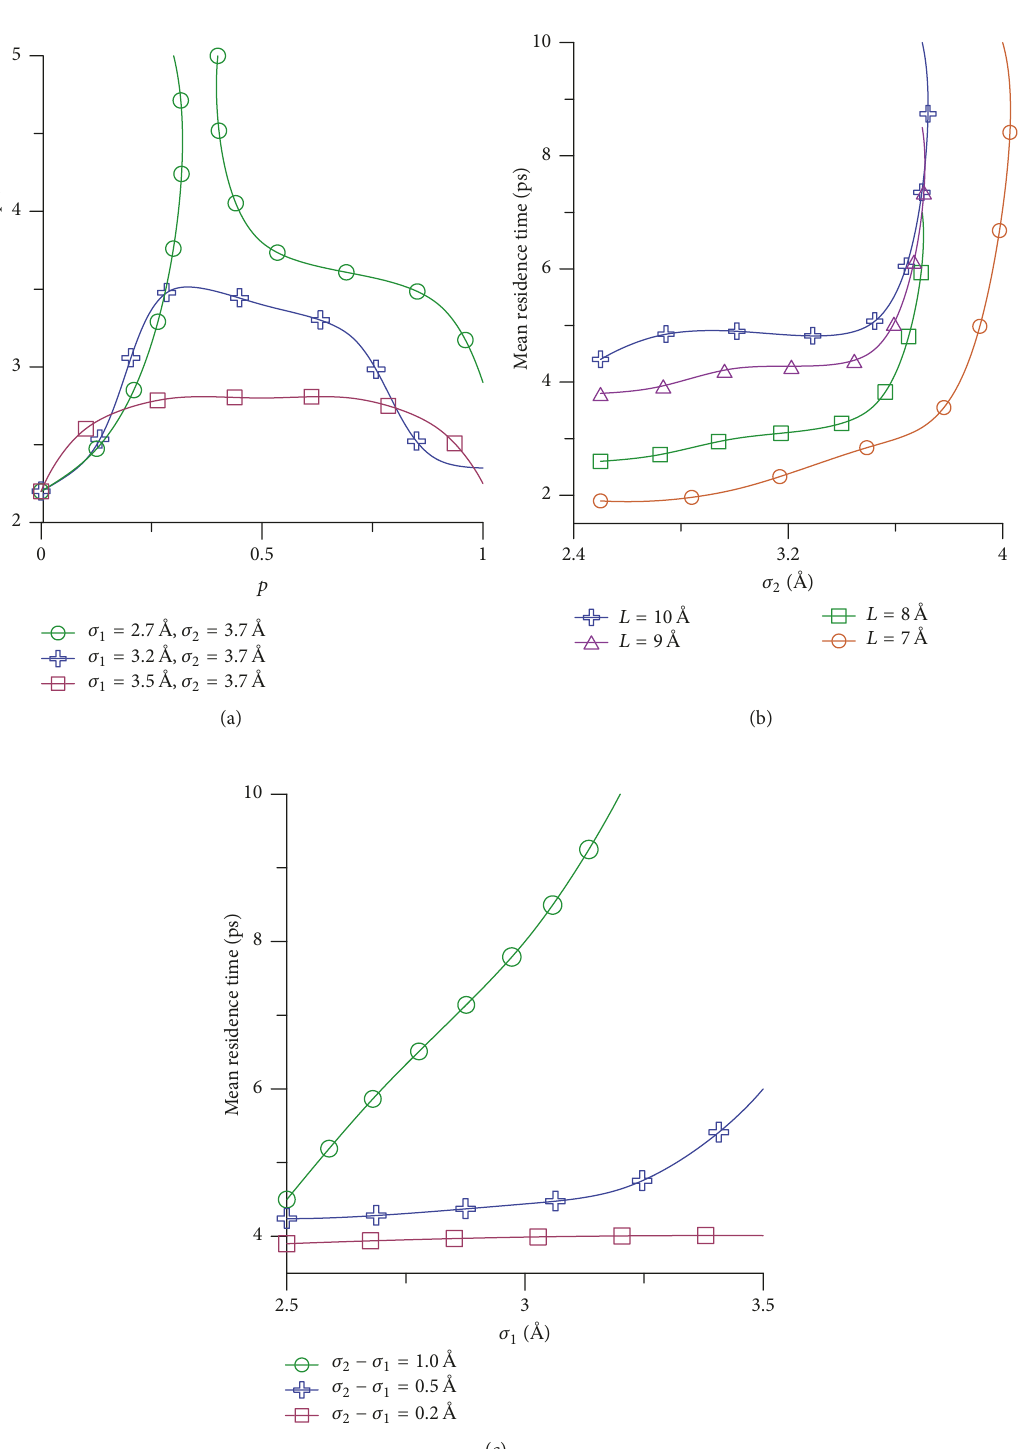
Figure 2: (a) The mean value of residence time 𝑡 against 𝑝 for molecules with length 𝐿 = 8 ˚A and different potential parameters (𝜎 1 , 𝜀 1 ; 𝜎 2 , 𝜀 2 ) at temperature 𝑇 = 293 K. (b) The mean value of 𝑡 against 𝜎 2 (each 𝜎 2 with the corresponding 𝜀 2 ) for linear molecules with 𝜎 1 = 2.5 ˚A, 𝜀 = 0.07 kcal/mol, 𝑝 = 0.5 , 𝑇 = 293 K, and different lengths. (c) The mean value of 𝑡 against 𝜎 1 molecules with length 𝐿 = 9 ˚A, 𝑝 = 0.5 , 𝑇 = 293 K, and different values of 𝜎 2 − 𝜎 1